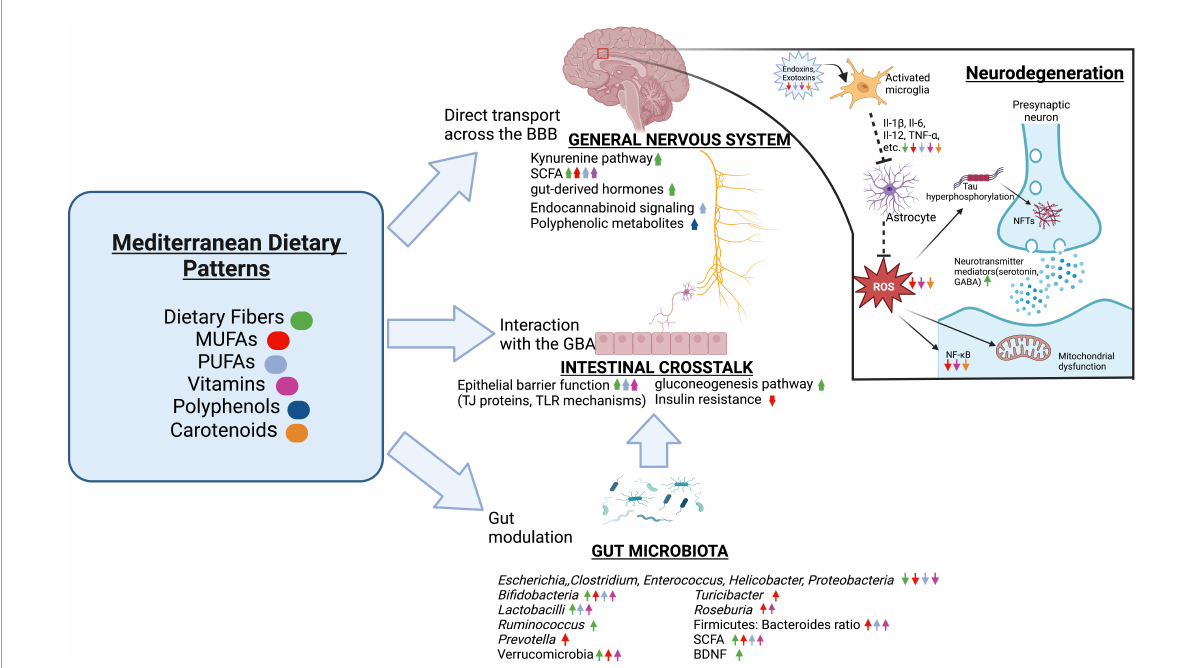
FIGURE3 The effects of Mediterranean dietary components on the GBA. Dietary fibers, MUFAs, PUFAs, vitamins, polyphenols, carotenoids, and other bioactive compounds have been found to stimulate SCFA-producing organisms while inhibiting pathogenic bacteria, reducing endotoxemia and inflammatory pathways such as NF- κ B, protecting gut barrier integrity independently of the gut microbiota, and promoting the production and translocation of neuroactive molecules across the tightly regulated BBB to directly influence the CNS. Additionally, many components of the Mediterranean dietary pattern neutralize oxidative stress and protect against apoptosis. The color of the arrows correspond to one of the six dietary components, where an up arrow represents the promotion of a factor of the GBA while a down arrow represents the inhibition of said factor. SCFA, short-chain fatty acid; BBB, blood-brain barrier; BDNF, brain-derived neurotrophic factor; TJ, tight junction; TLR, toll-like receptor; MUFAs, monounsaturated fatty acids; PUFAs, polyunsaturated fatty acids; LPS, lipopolysaccharide; IL-1 β , Interleukin 1-beta; TNF- α , tumor necrosis factor-alpha; NO, nitric oxide; ROS, reactive oxygen species; GABA, gamma aminobutyric acid; NF- κ B, Nuclear factor- κ B; GBA, gut-brain axis. We have obtained the appropriate licenses from BioRender for this